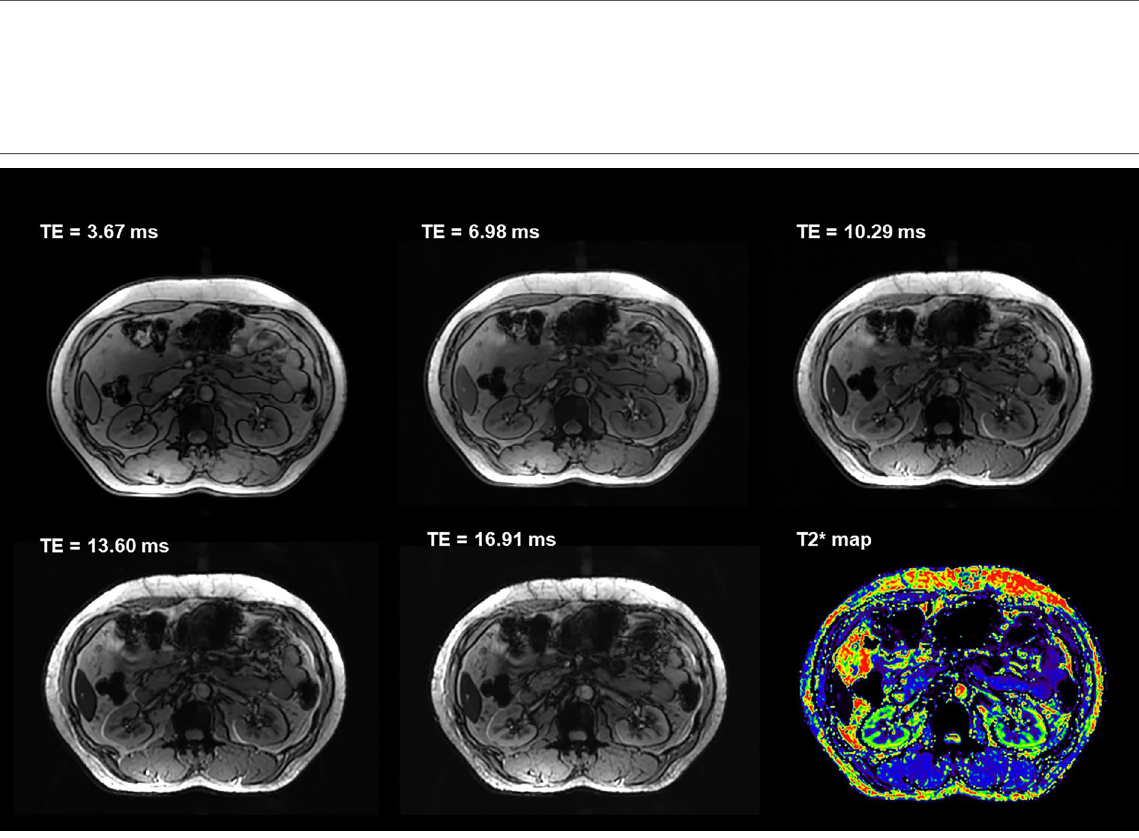
Fig. 3 Diffusion-weighted images and corresponding apparent diffusion coefficient map at 3 T ( a and c ) and 5 T ( d and f ) from a 42-year-old female